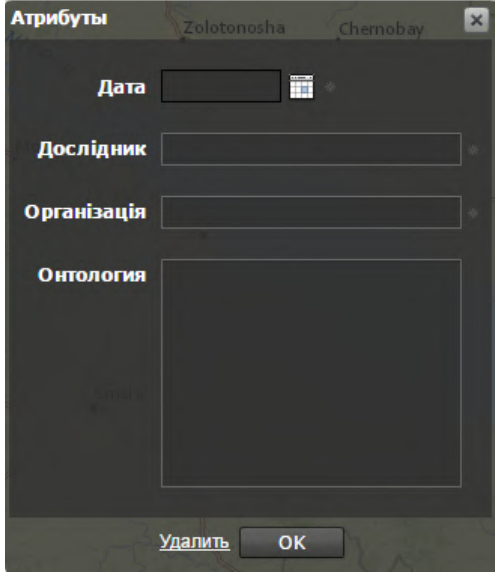
Figure 8: GIS data input table.